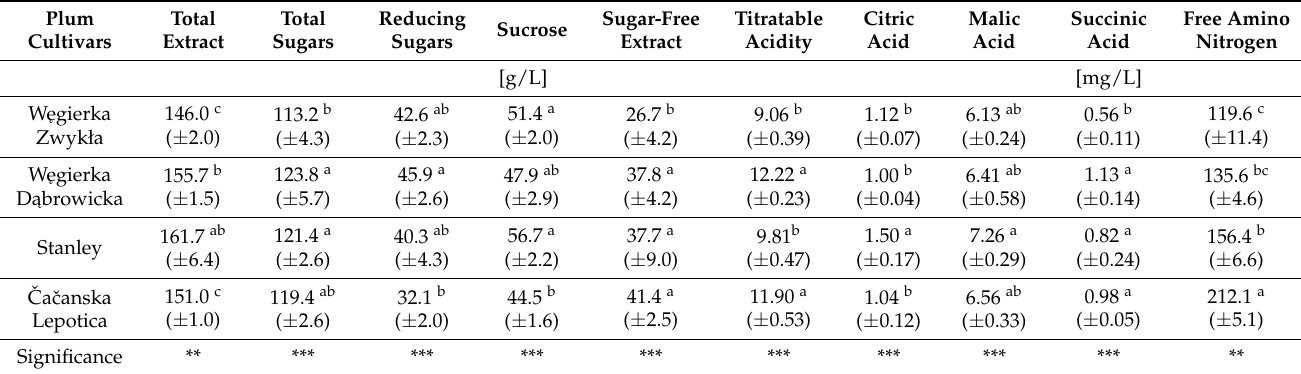
Table 1. Chemical composition of fresh plum